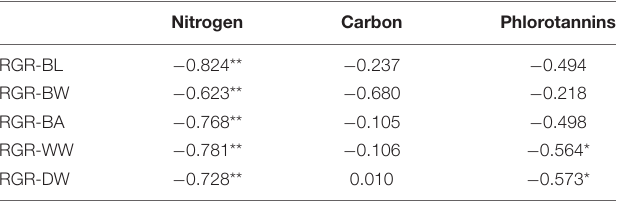
TABLE 3 | Correlation coefficients between RGRs and chemical compositions of E. bicyclis juvenile sporophytes cultured at two different temperatures.